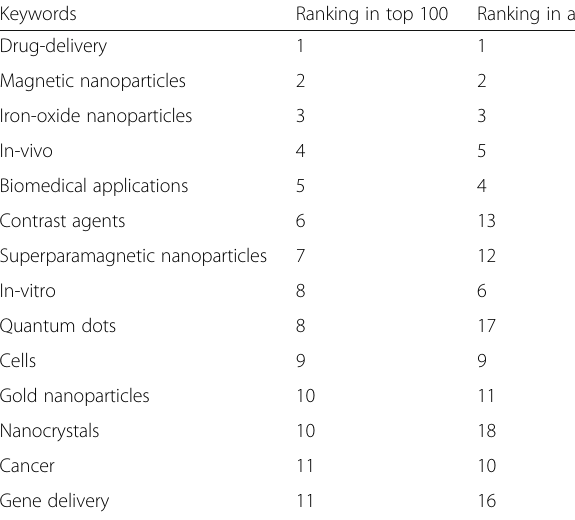
Table 3 Comparing keywords ranking in the top 100 best cited papers with keywords ranking in all